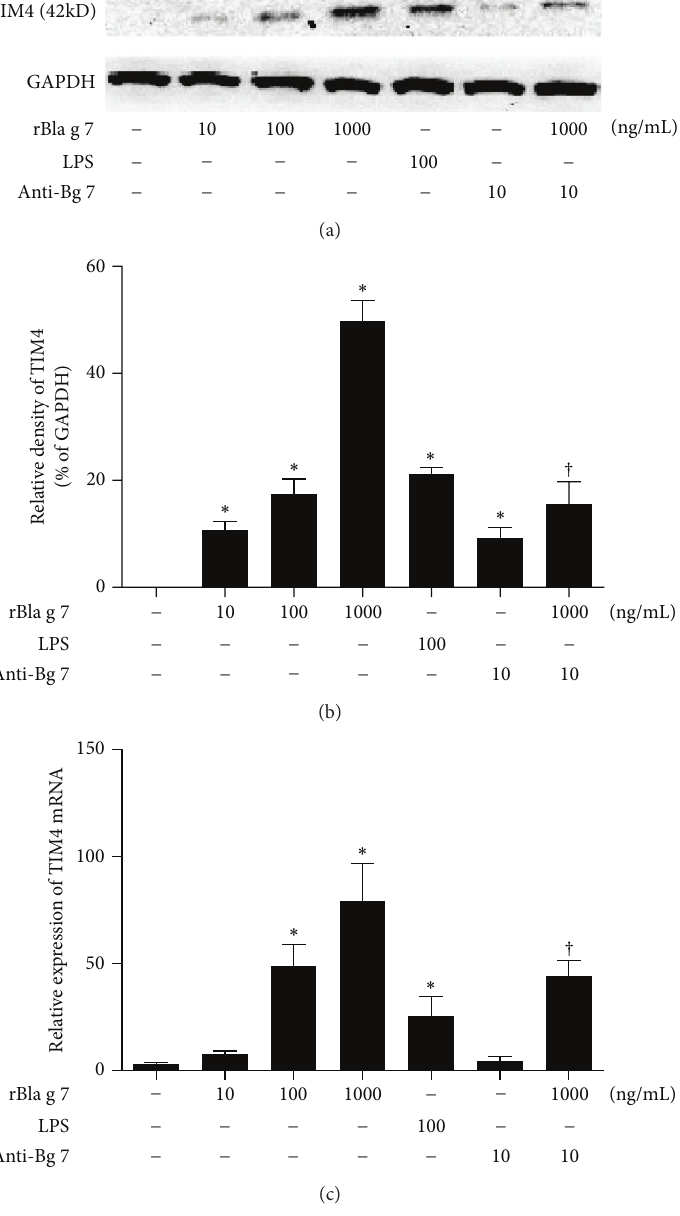
Figure 1: rBla g 7 induced the expression of TIM4 in dendritic cells (DCs). Various concentrations of rBla g 7 or LPS (100ng/mL) were incubated with DCs for 48h at 37 ∘ C. (a) Western blot analysis of TIM4 expression in DCs, (b) density analysis of TIM4 expression in Western blot, and (c) real-time PCR to determine the relative expression of TIM4 mRNA in DCs. The expression values were normalized against GAPDH mRNA, and relative gene expression was determined by the 2 −ΔΔ ct method. The data were represented as the mean ± SEM for four separate experiments. ∗ 𝑃 < 0.05 in comparison with medium alone control. † 𝑃 < 0.05 compared with the response to the corresponding uninhibited